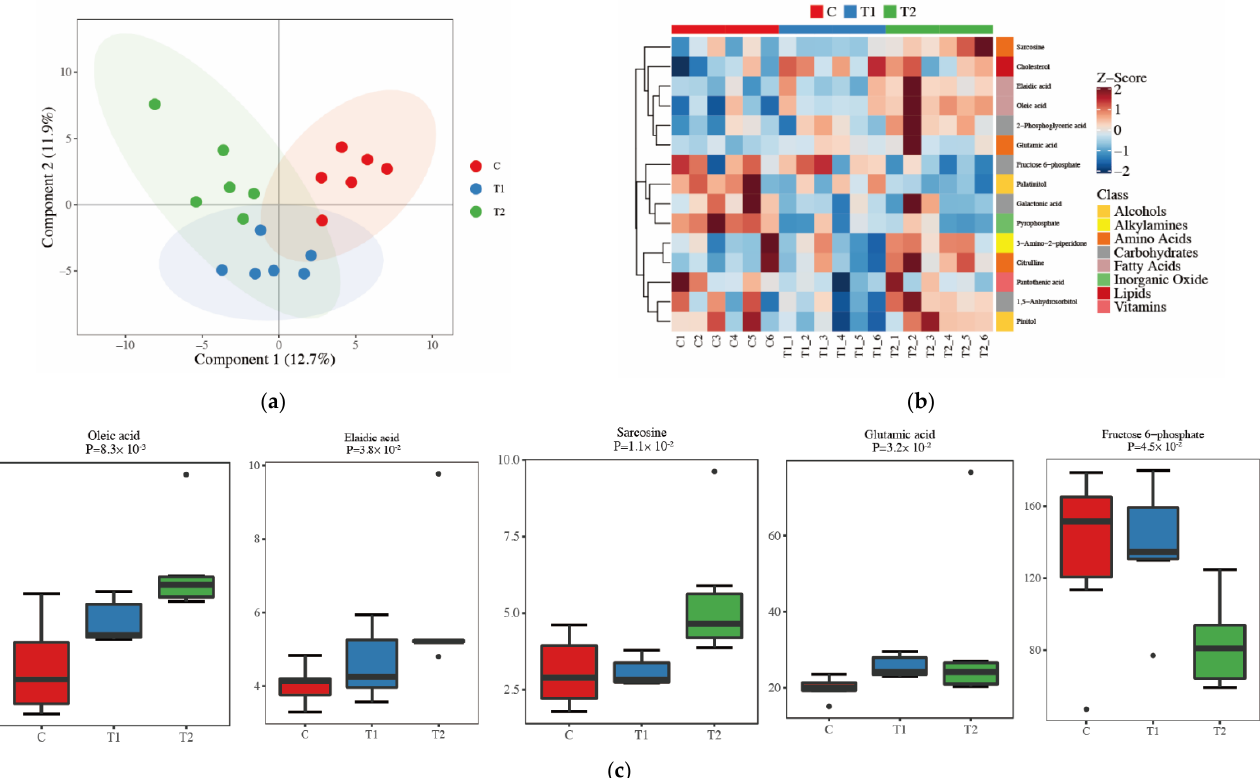
Table 5, all detected free amino acids are sorted in the table according to their taste.